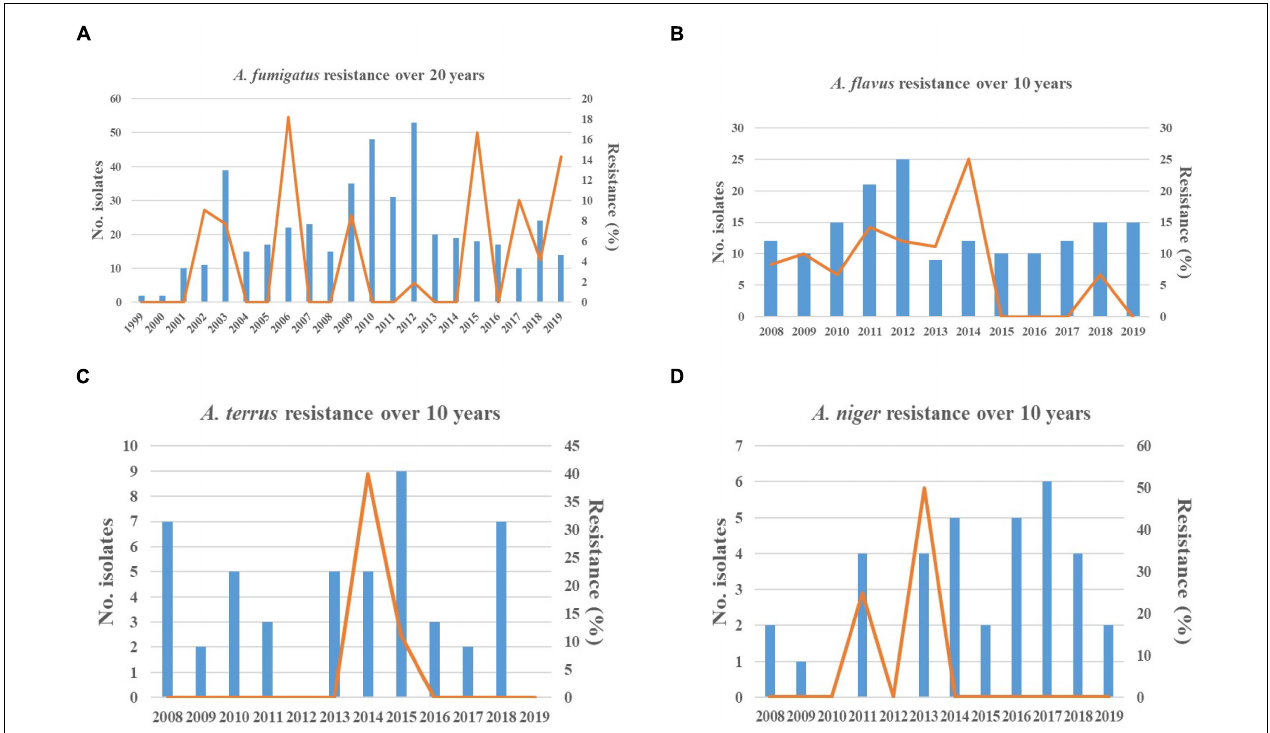
FIGURE 2 | Resistance trends of Aspergillus spp. isolates collected over 20 years. Blue histograms: the total number of Aspergillus isolates collected each year. Yellow solid line: the frequency of resistant Aspergillus isolates each year. (A) The increasing trend in resistance of Aspergillus fumigatus was observed. (B) The decreasing trend in resistance of Aspergillus flavus was observed. (C,D) The trends in susceptibility of Aspergillus terreus and Aspergillus niger were